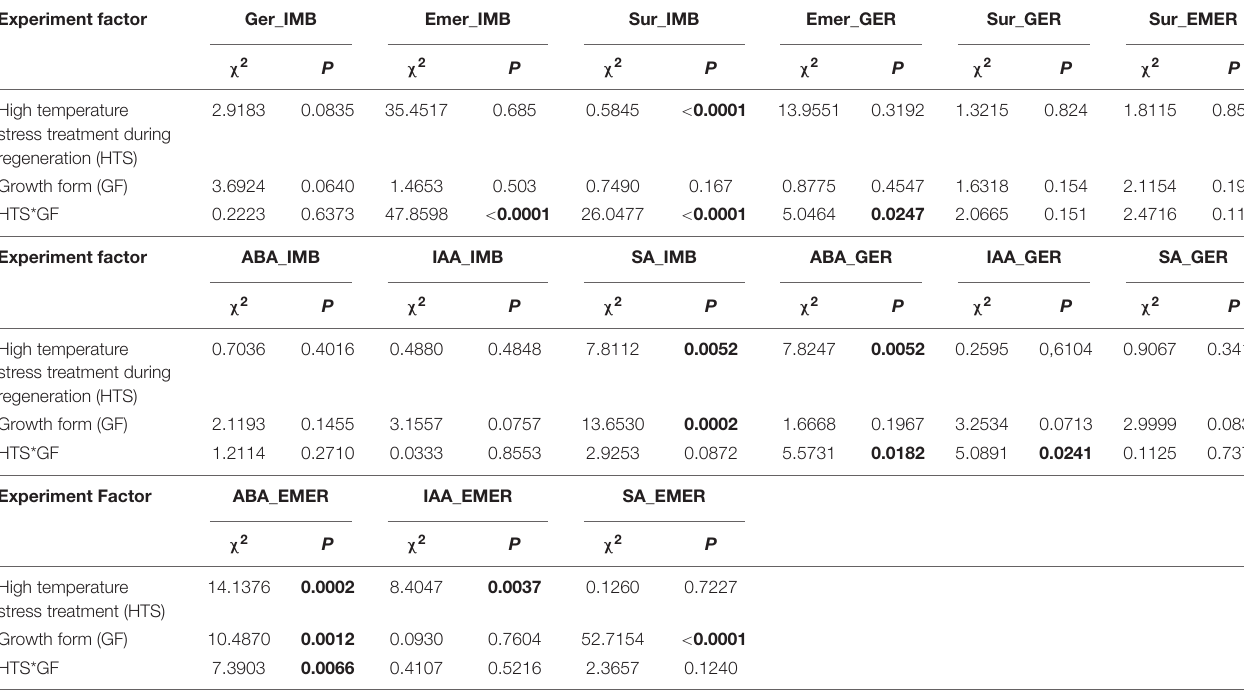
TABLE 2 | Chi-square and P values for the effects of the high-temperature stress treatment (HTS) on the early regeneration probability (Ger, Emer, and Sur) and phytohormone response (ABA, IAA, and SA) and the interaction by growth form. Experiment